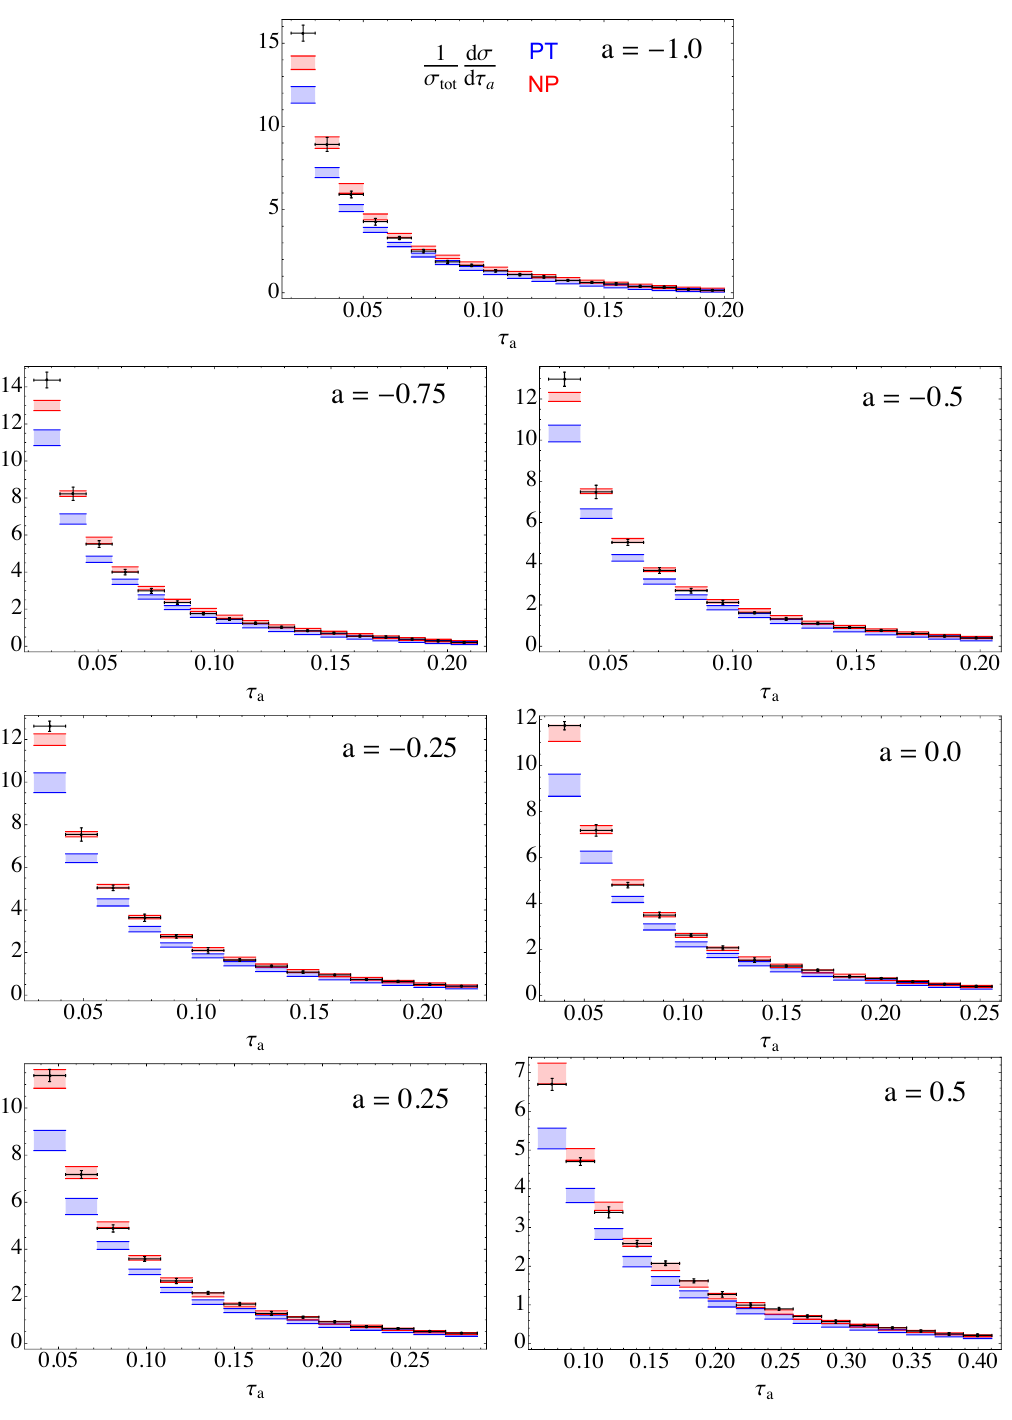
Figure 15 . NNLL 0 resummed and ( (cid:11) 2 ) matched angularity distributions for all values of a con- s O sidered in this study, a 1 : 0 ; 0 : 75 ; 0 : 5 ; 0 : 25 ; 0 : 0 ; 0 : 25 ; 0 : 5 , at Q = m Z , with (cid:11) s ( m Z ) = 0 : 11. 2 f(cid:0) (cid:0) (cid:0) (cid:0) g The blue bins represent the purely perturbative prediction and the red bins include a convo- lution with a gapped and renormalon-subtracted shape function, with a (cid:12)rst moment set to (cid:10) 1 ( R (cid:1) ; R (cid:1) ) = 0 : 4 GeV. Overlaid is the experimental data from [52].